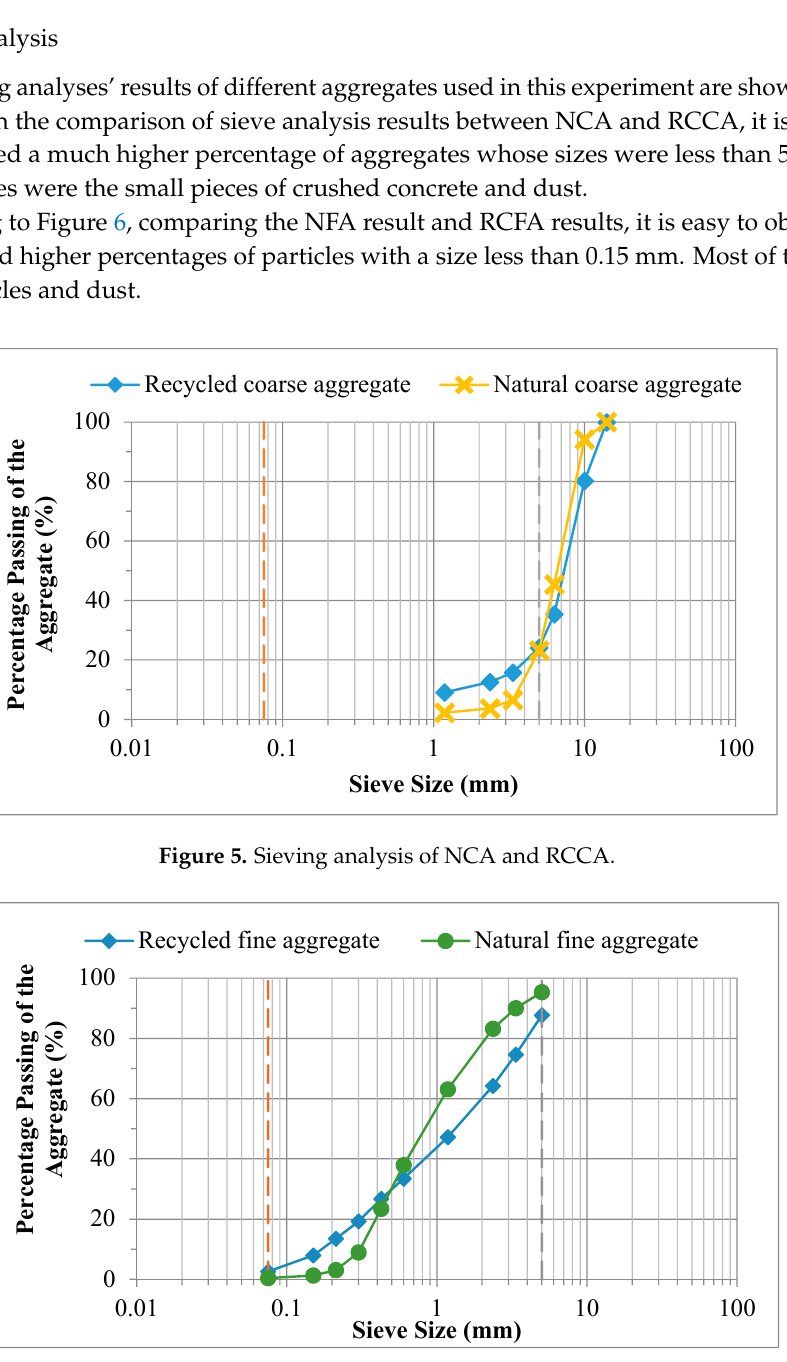
Figure 6. Sieving analysis of NFA and RCFA.